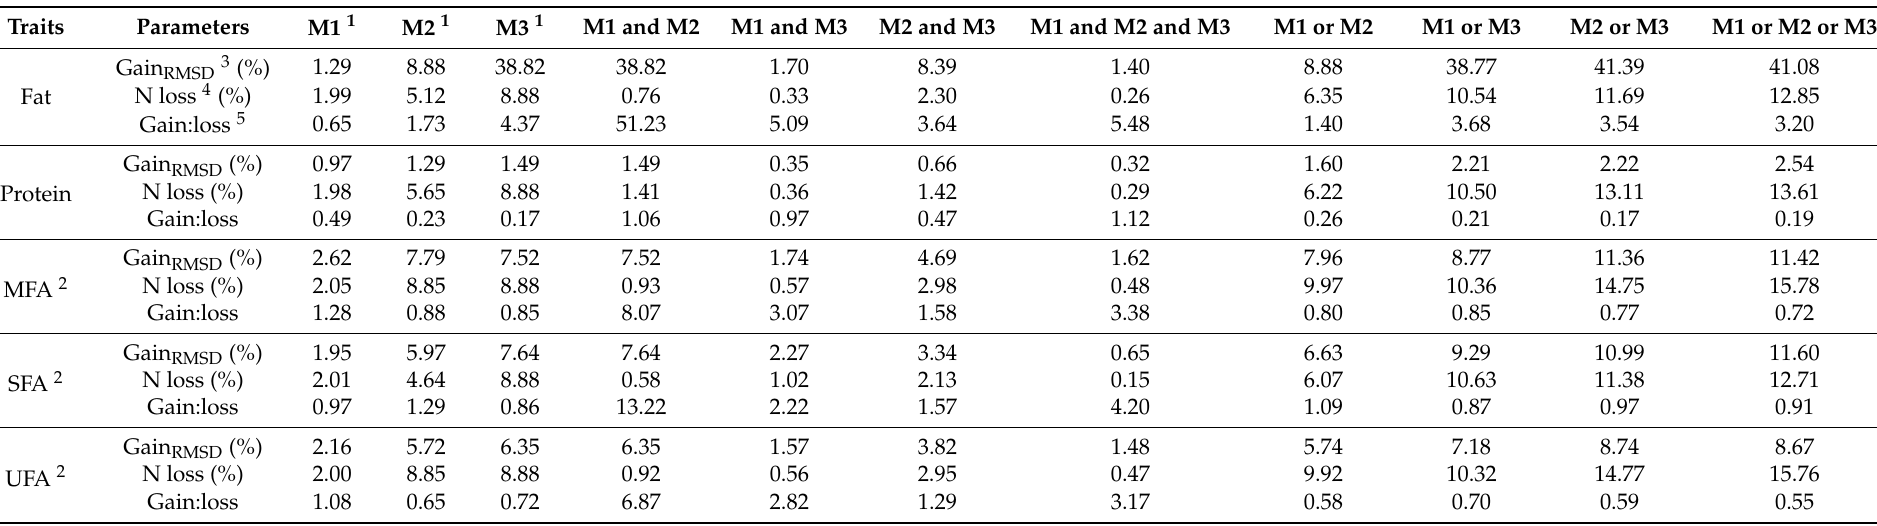
Table 7. Interest of using the three studied data-cleaning methods and their combinations to clean the raw dataset.